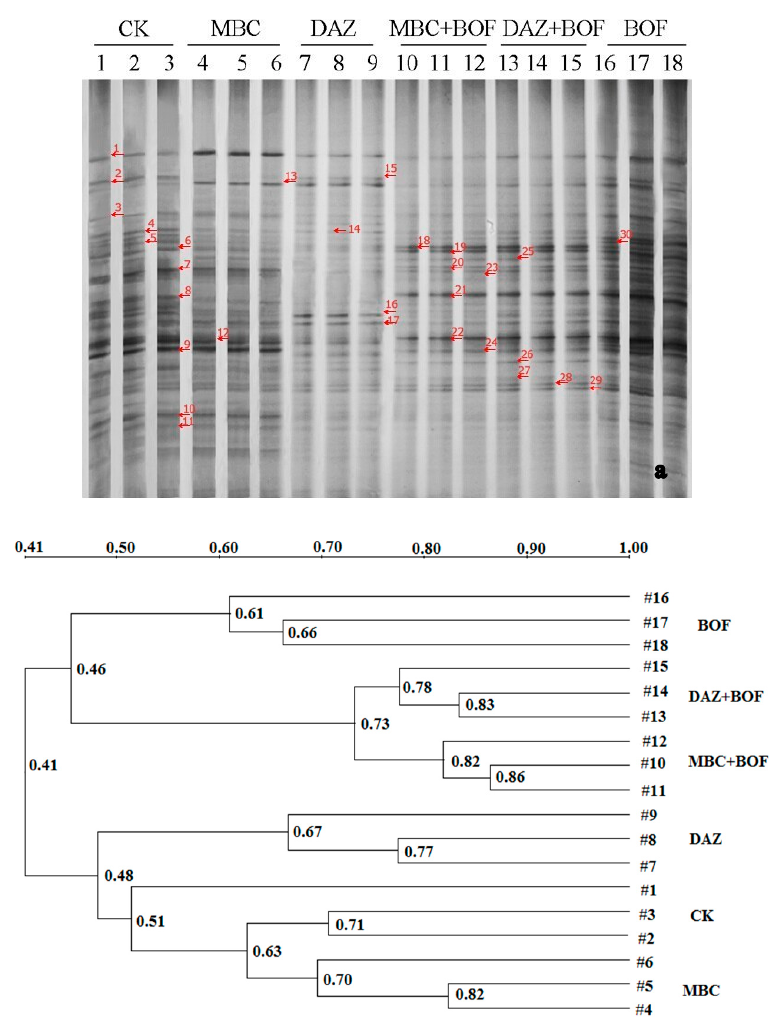
Figure 3. Cont. Figure 3.